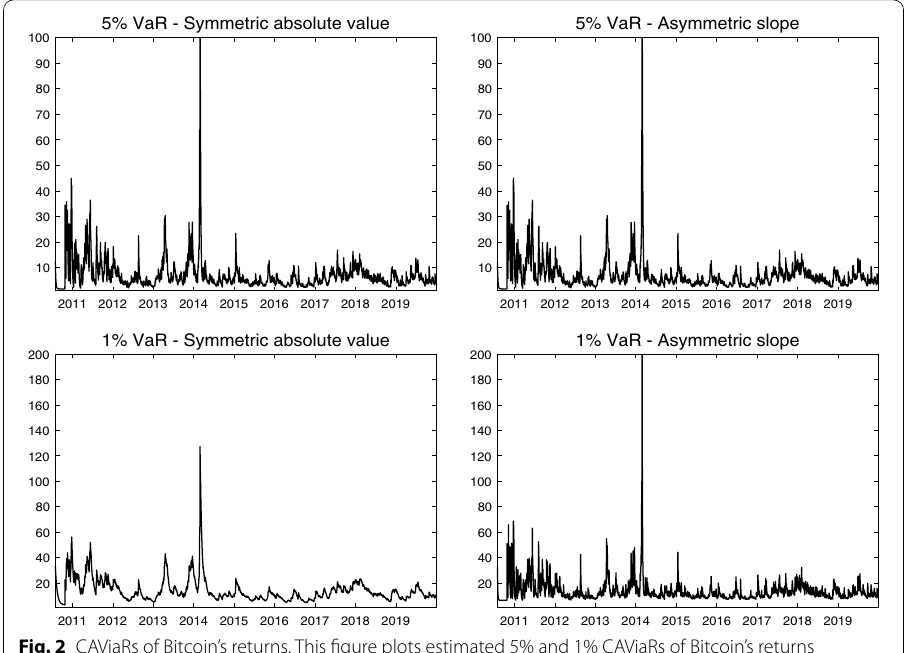
Fig. 2 CAViaRs of Bitcoin’s returns. This figure plots estimated 5% and 1% CAViaRs of Bitcoin’s returns adopting symmetric absolute value and asymmetric slope specifications. The sample period is from August